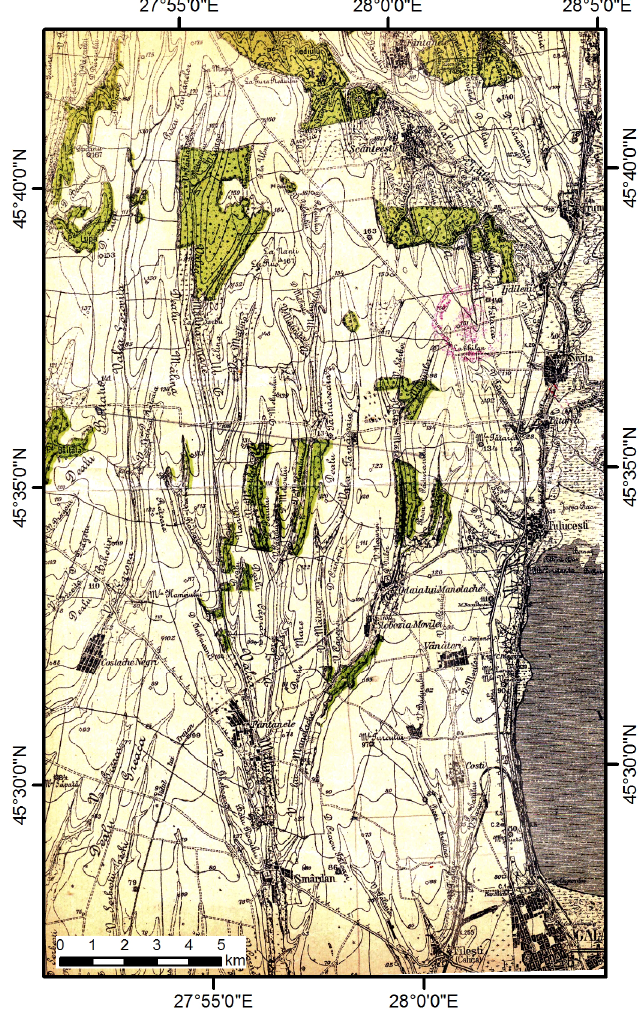
Figure 6. Forest areas (1892–1893) north of the study region [64].